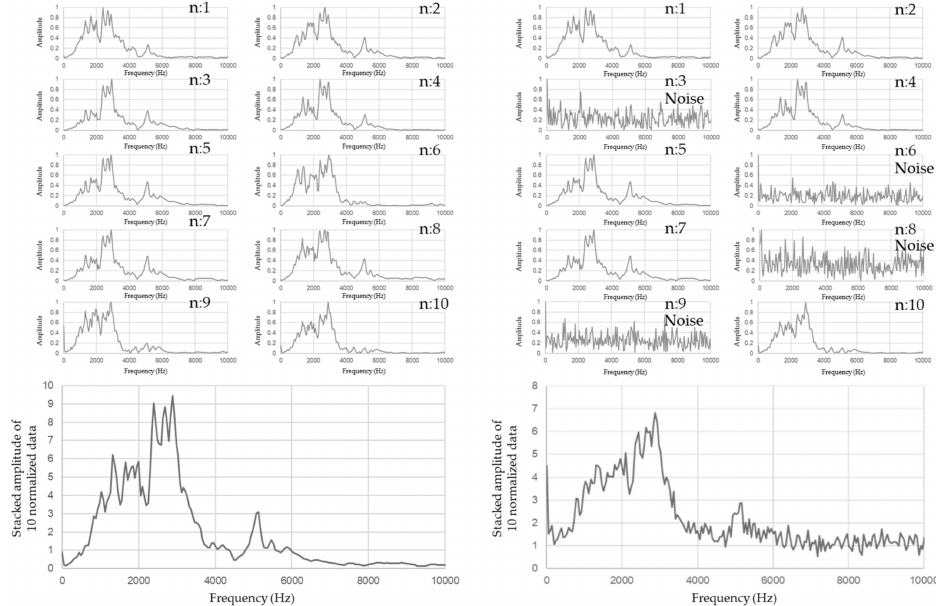
Figure 7. FFT signal data stacking